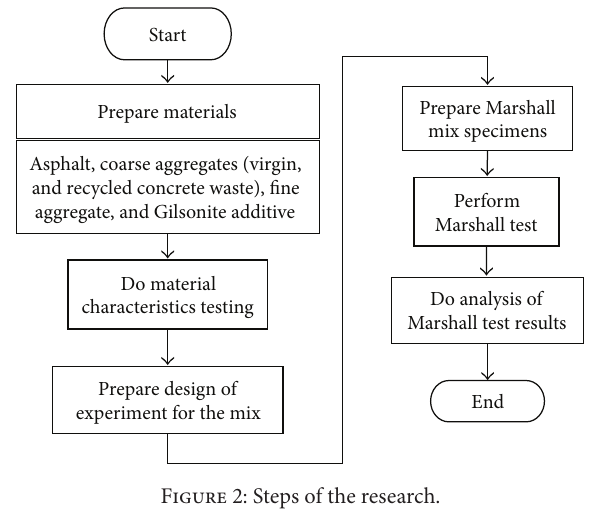
Figure 2: Steps of the research.